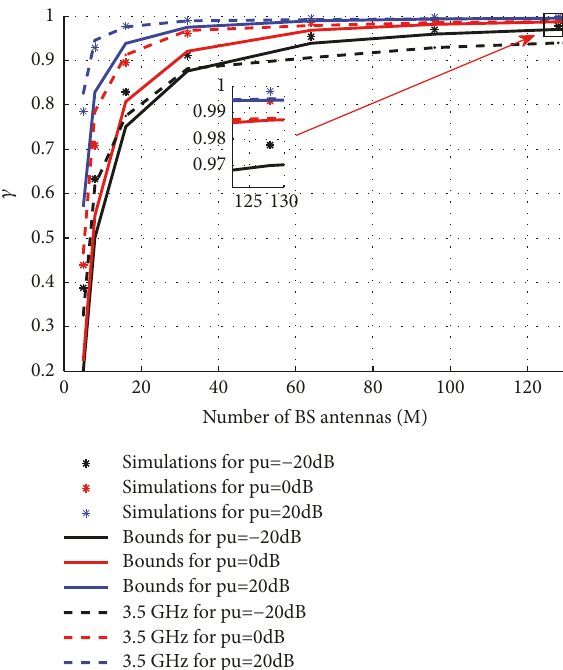
Figure 5: Simulation and 3.5 GHz measurement results of 𝛾 versus different numbers of BS antennas with different transmit